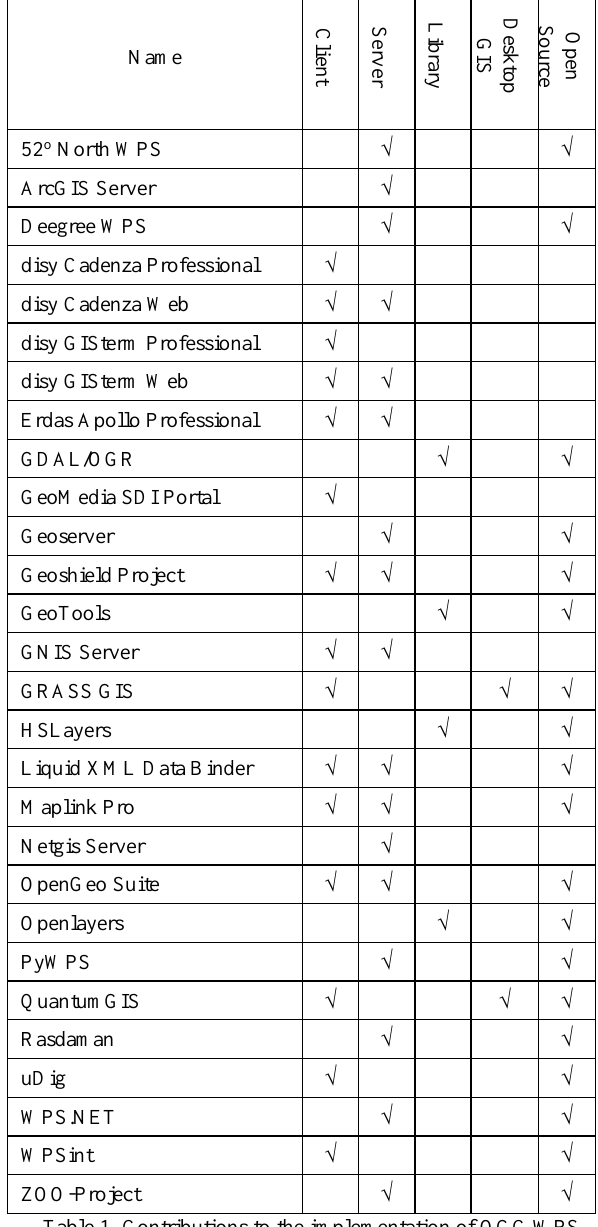
Table 1. Contributions to the implementation of OGC WPS specification standard (Evangelidis, et al., 2014)